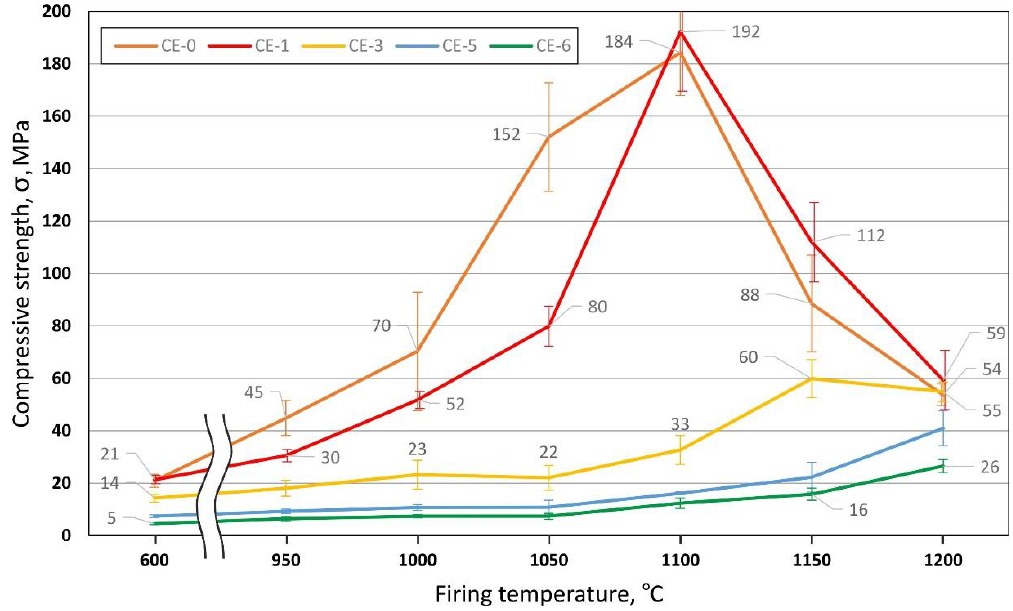
Figure 8. Compressive strength dependence on the CS content and the firing